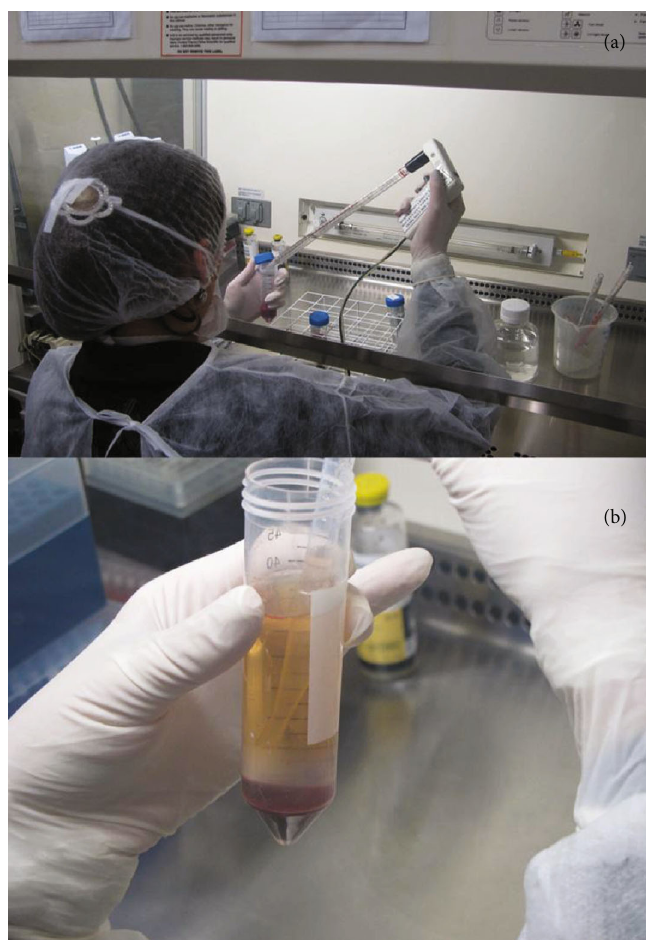
Figure 1: (a, b) Sequence of images showing the separation of mononuclear cells after centrifugation by Ficoll Hystopaque